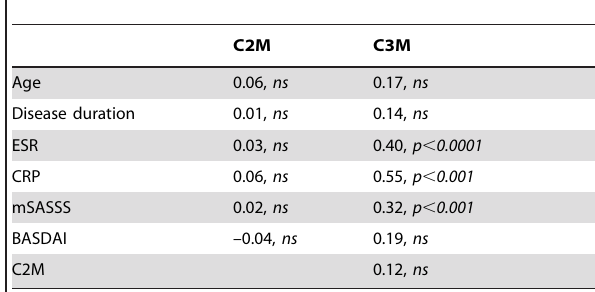
Table 4. Univariate analysis for C2M and C3M associations with age, disease duration and AS clinical characteristics; erythrocyte sedimentation rate (ESR), high sensitive C-reactive protein (CRP), mSASSS and